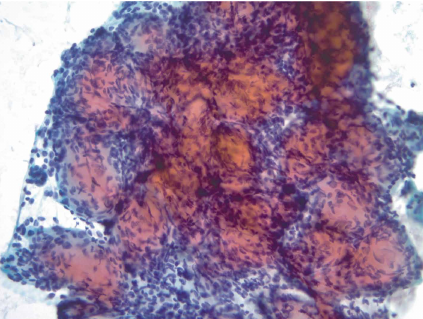
Figure 1: Magnetic resonance imaging (MRI) confirmed a 4.6 cm relatively well circumscribed, hypervascular, enhancing mass (circled) in the distal pancreatic body with no associated pancreatic ductal dilatation.